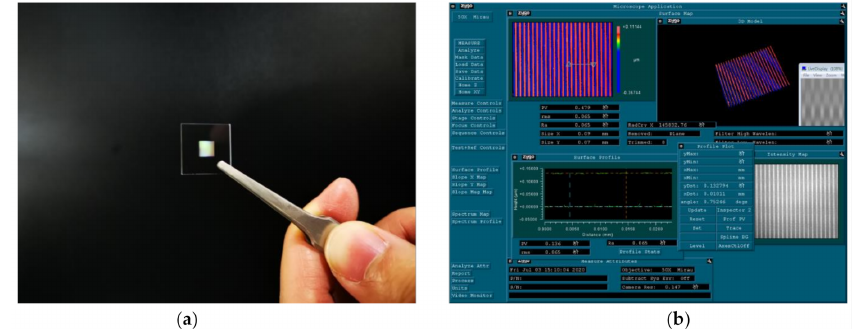
Figure 10. ( a ) Photograph of a fabricated sample. ( b ) Morphology depth characterization diagram of the grating using a ZYGO white light interferometer.